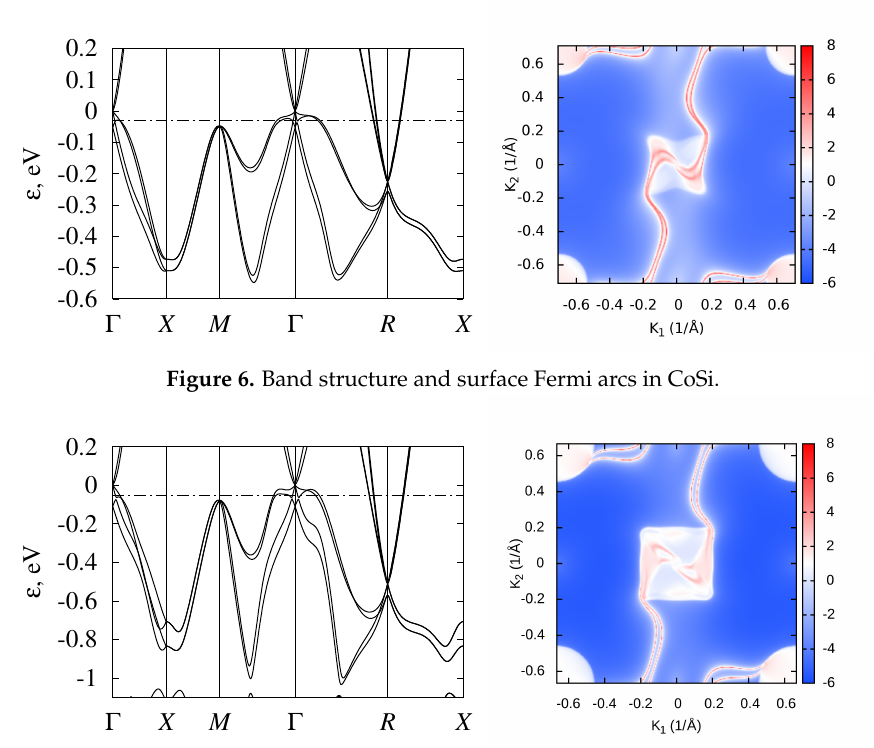
Figure 7. Band structure and surface Fermi arcs in RhSi.